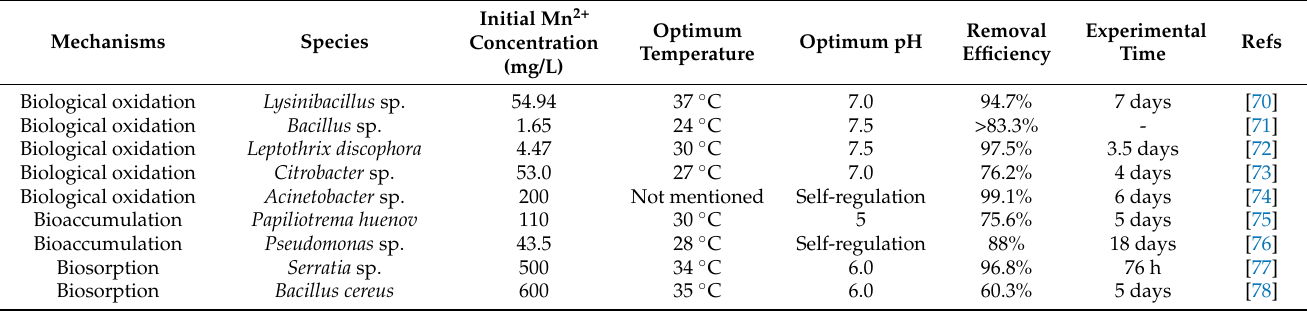
Table 2. Common bacteria for Mn removal via various mechanisms, including bio-oxidation, bioac- cumulation and adsorption at their optimal